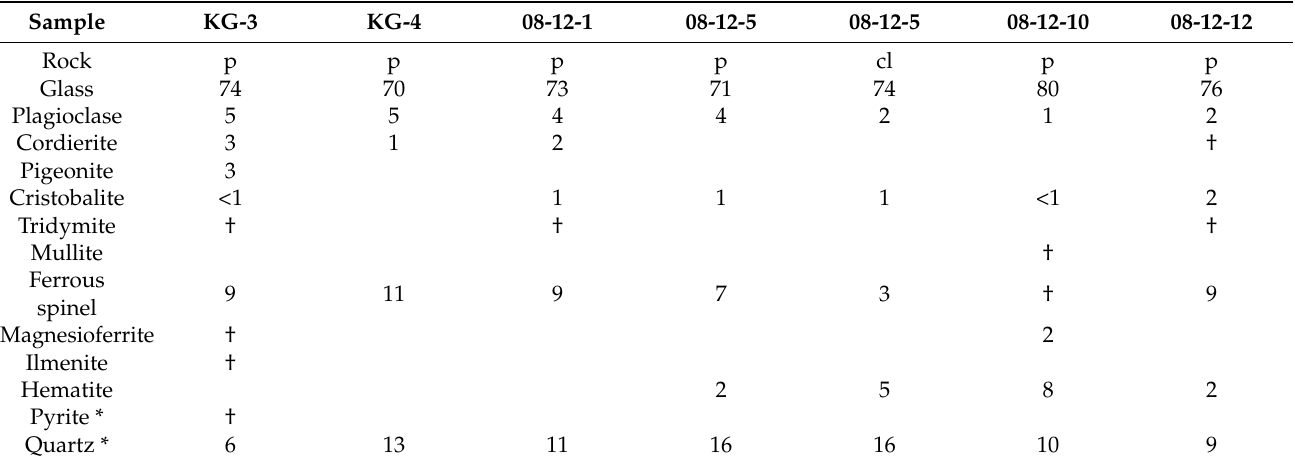
Table 2. Mineral assemblages in metapelitic combustion metamorphic rocks from Karabetova Gora MV (Taman Peninsula) determined by XRD.